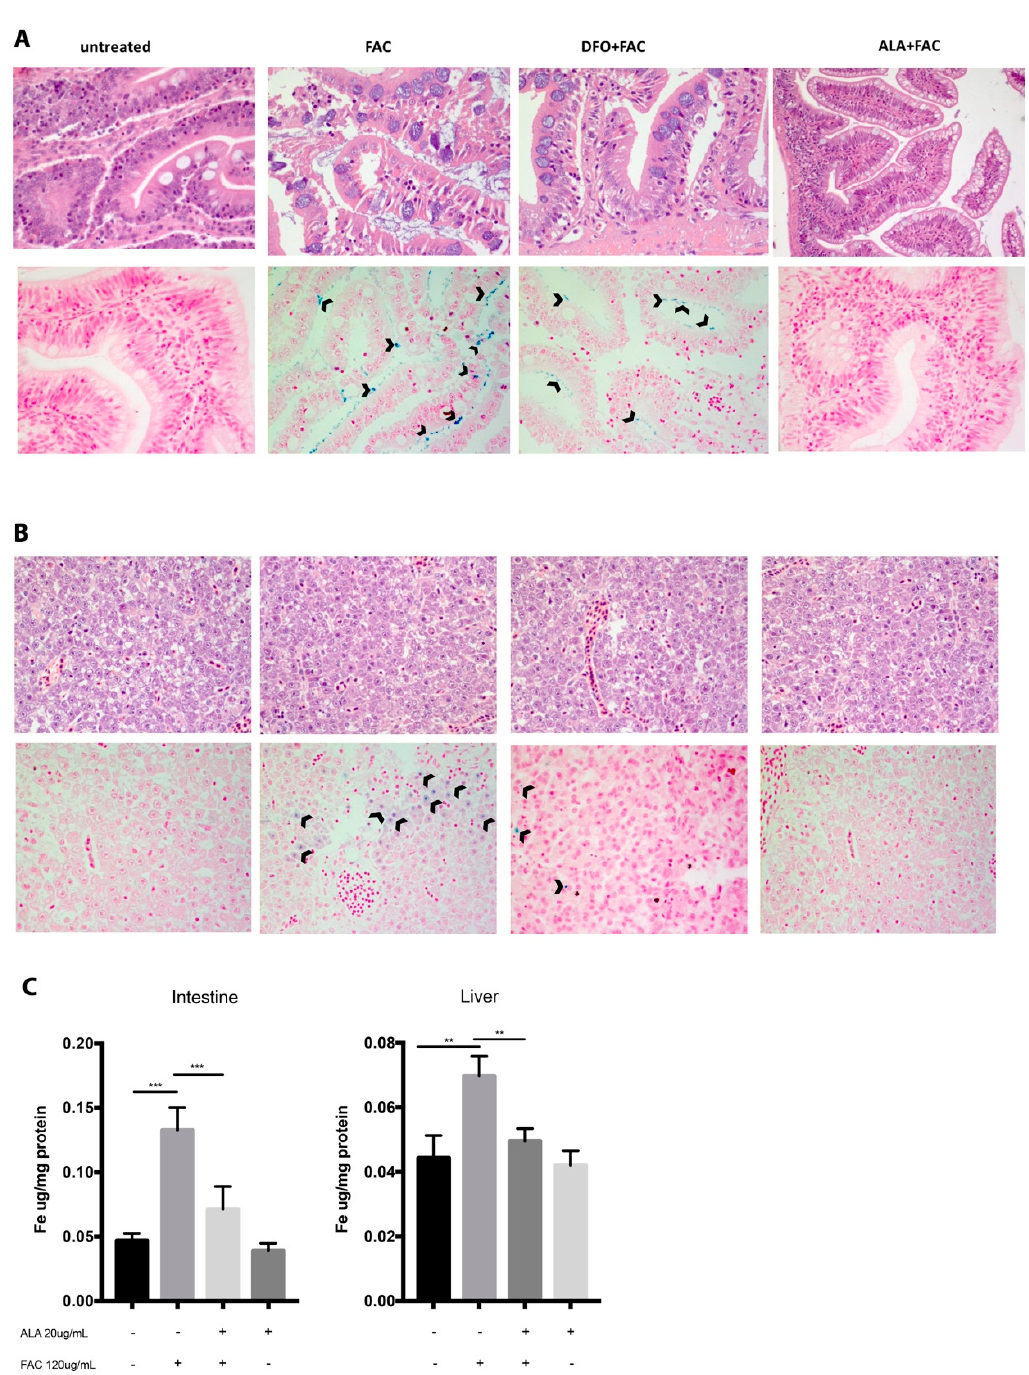
Figure 5. ALA protected against histopathological alterations and iron stores induced by iron overload in zebrafish intestine ( A ) and liver ( B ). Hematoxylin-Eosin staining showed histological damage induced by FAC (120 µg/mL for 48 h) treatment alone or in combination with ALA (20 µg/mL) or DFO (131 µg/mL). Perls staining was performed to detect iron stores following FAC treatment and in combination with ALA or DFO. Arrows indicate iron stores both in intestinal epithelium cells and hepatic cells. (Magnification 40×; scale bars indicate 50 µm). Iron level determination by ICP-OES ( C ). Results are expressed as the means ± SD of at least three independent experiments; ** p <0.001, *** p <0.0001.